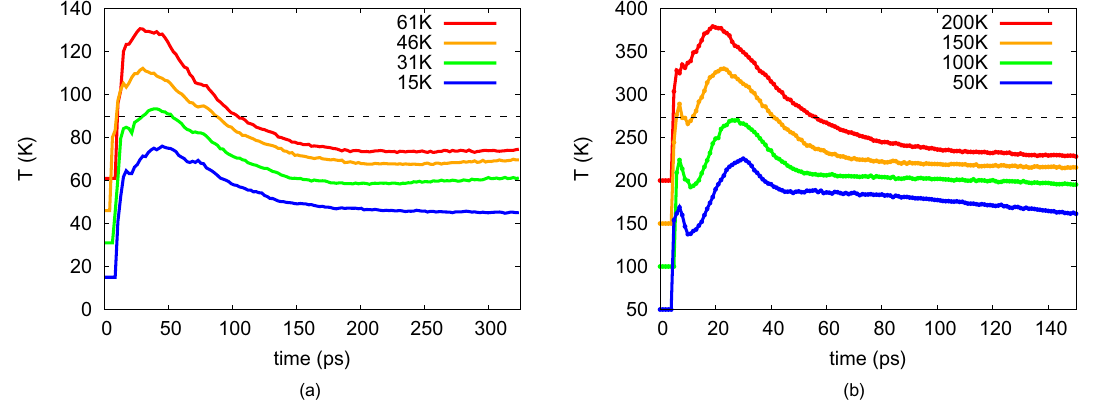
Figure 2. Time evolution of the temperature in the collision zone for ( a ) Ar and ( b ) water NP collisions for the initial temperatures T 0 indicated. The horizontal dashed line marks the triple-point temperature.